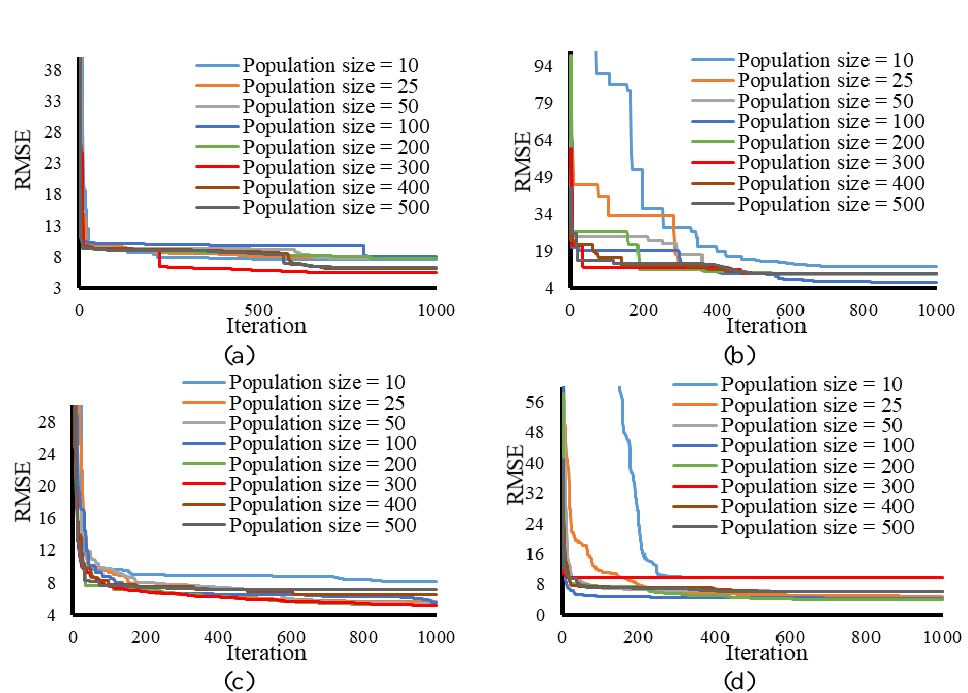
Figure 3. The trial and error-based optimization of the ( a ) HHO – ANFIS, ( b ) SSA – ANFIS, ( c ) TLBO –